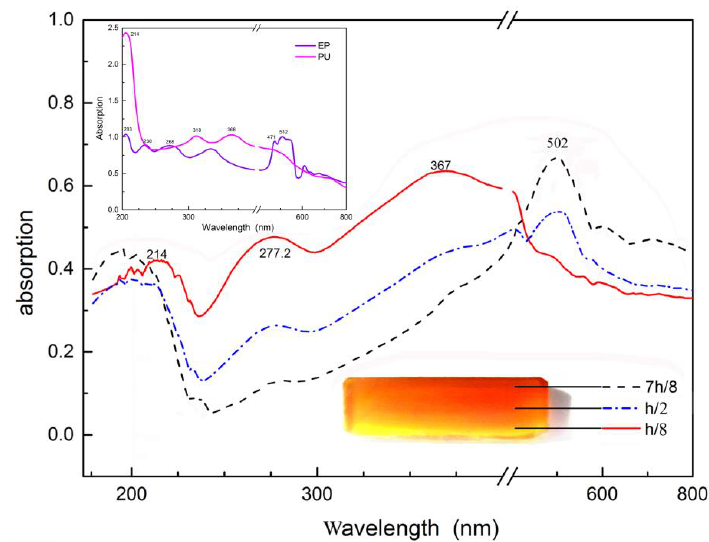
Figure 3. Ultraviolet absorption spectrum (UV-Vis) absorption spectra of the chosen regions in the gradientinterpenetrating polymer network (IPN). The top left insert is the absorption spectra of PU and EP. Here “h” represents the thickness.